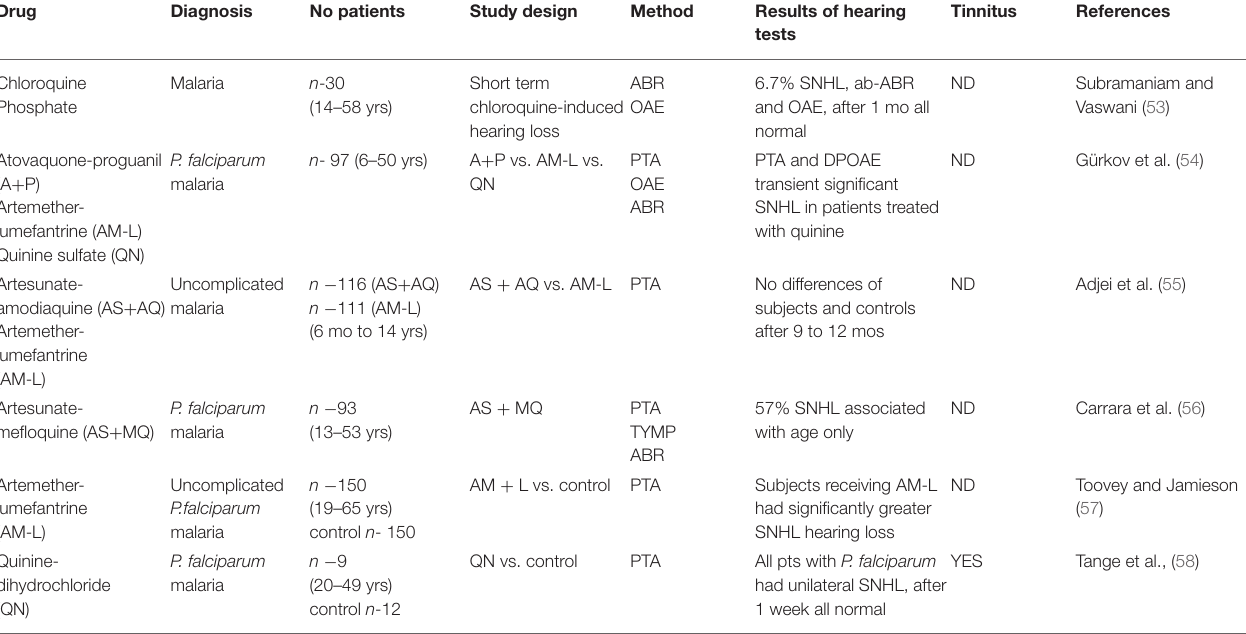
TABLE 2 | Drugs associated with cochlear